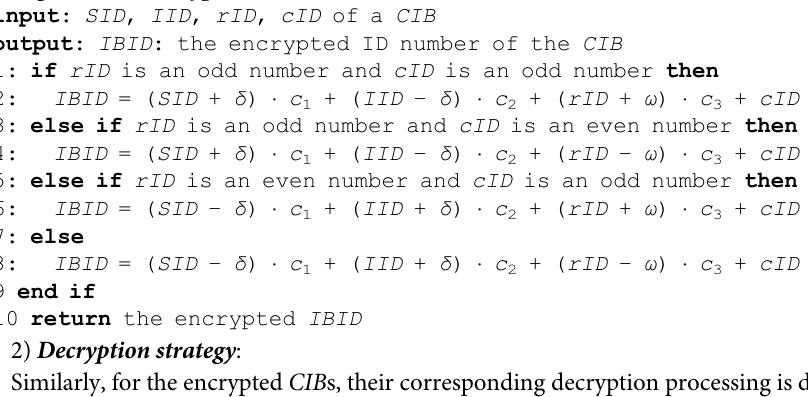
Algorithm 2 details the steps of the CIB -based encryption processing in which the ID num- bers of the CIB s are encrypted, where δ and ω are two key values and δ < SID , δ < IID and ω Algorithm 2